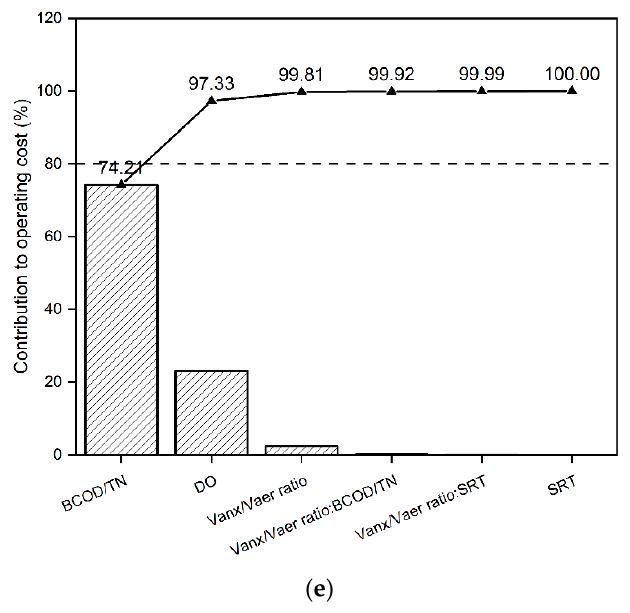
Figure 3. Pareto diagram of removal efficiencies of ( a ) NH 4+ -N, ( b ) TN, ( c ) TP, ( d ) COD, and ( e ) the operating cost. The filled rectangles represent the contribution rates of DOPs, the triangles represent cumulative contribution rates, and the horizontal dotted lines represent reference lines.